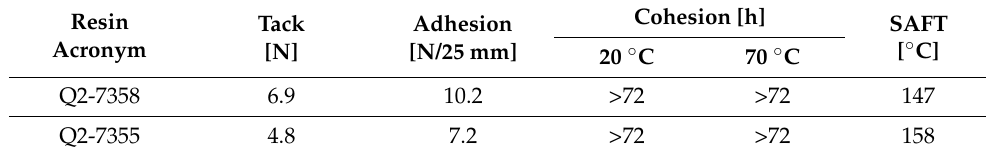
Table 2. Physical properties of one-side Si-PSA tape prepared without the filler.